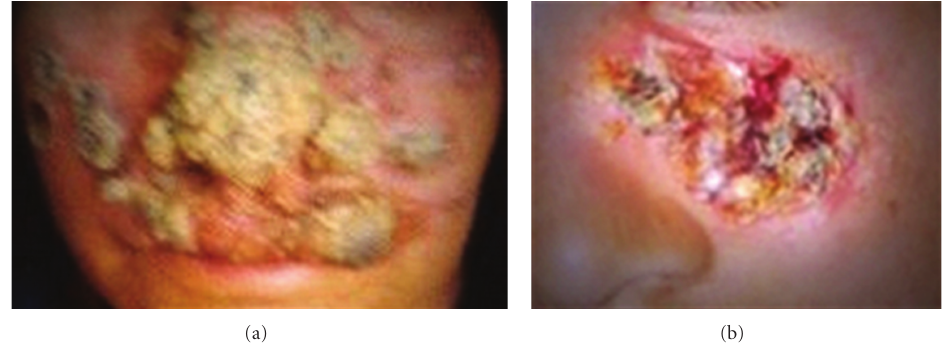
Figure 2: Disfiguring nature of lesions of CL on exposed parts of the body, particularly the face (copyright Kassi et al. [2]). Permission taken under creative commons attribution license.